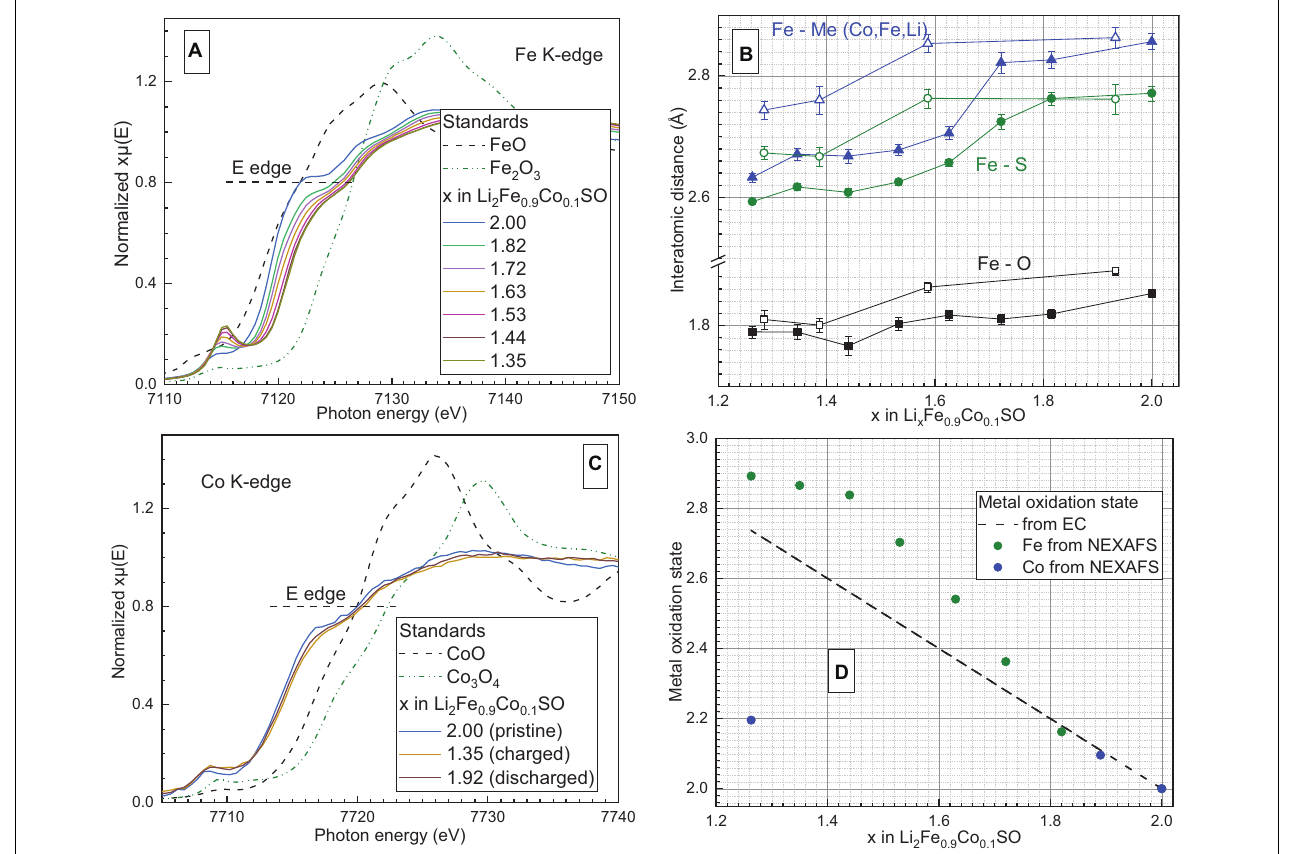
FIGURE 6 | (A) Normalized Fe K-edge X-ray absorption spectra of Li 2 Fe 0 . 9 Co 0 . 1 SO recorded operando . (B) Average interatomic distances between iron and other atoms estimated by extended X-ray absorption fine structure analysis with their confidence intervals. Filled points correspond to the charging process, unfilled–to the discharging. The scale of the Y-axis is the same before and after the break. (C) Normalized Co K-edge X-ray absorption spectra of the same material recorded operando . (D) Average oxidation states of metal cations in Li 2 Fe 0 . 9 Co 0 . 1 SO estimated from the electrochemical measurements (EC) and XAS studies. The position of the Fe K-edge was defined as the energy at the X-ray absorption coefficient µ (E) = 0.8 of normalized post-edge intensities, similar to Mikhailova et al. (2018) and Gorbunov et al. (2020).